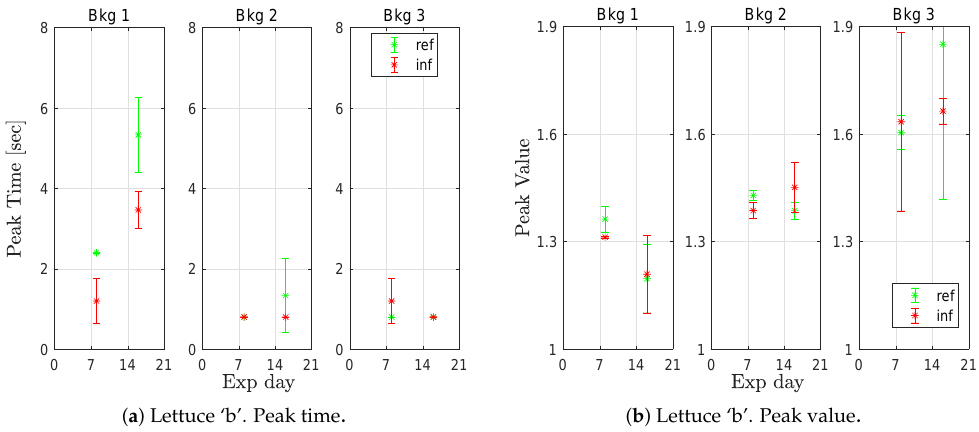
Figure 8. The fluorescence step response peak time ( a ) and peak value ( b ) for lettuce ‘b’ at three different background light levels. The mean value and std for two to five measurements each week and for each group (reference and infected with Pythium ultimum